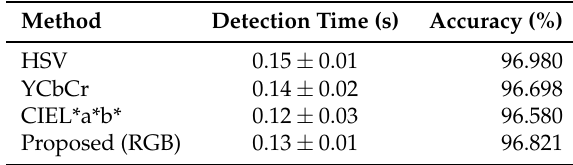
Table 4. Comparison results for receiver operating characteristic (ROI) extraction with different colour spaces.